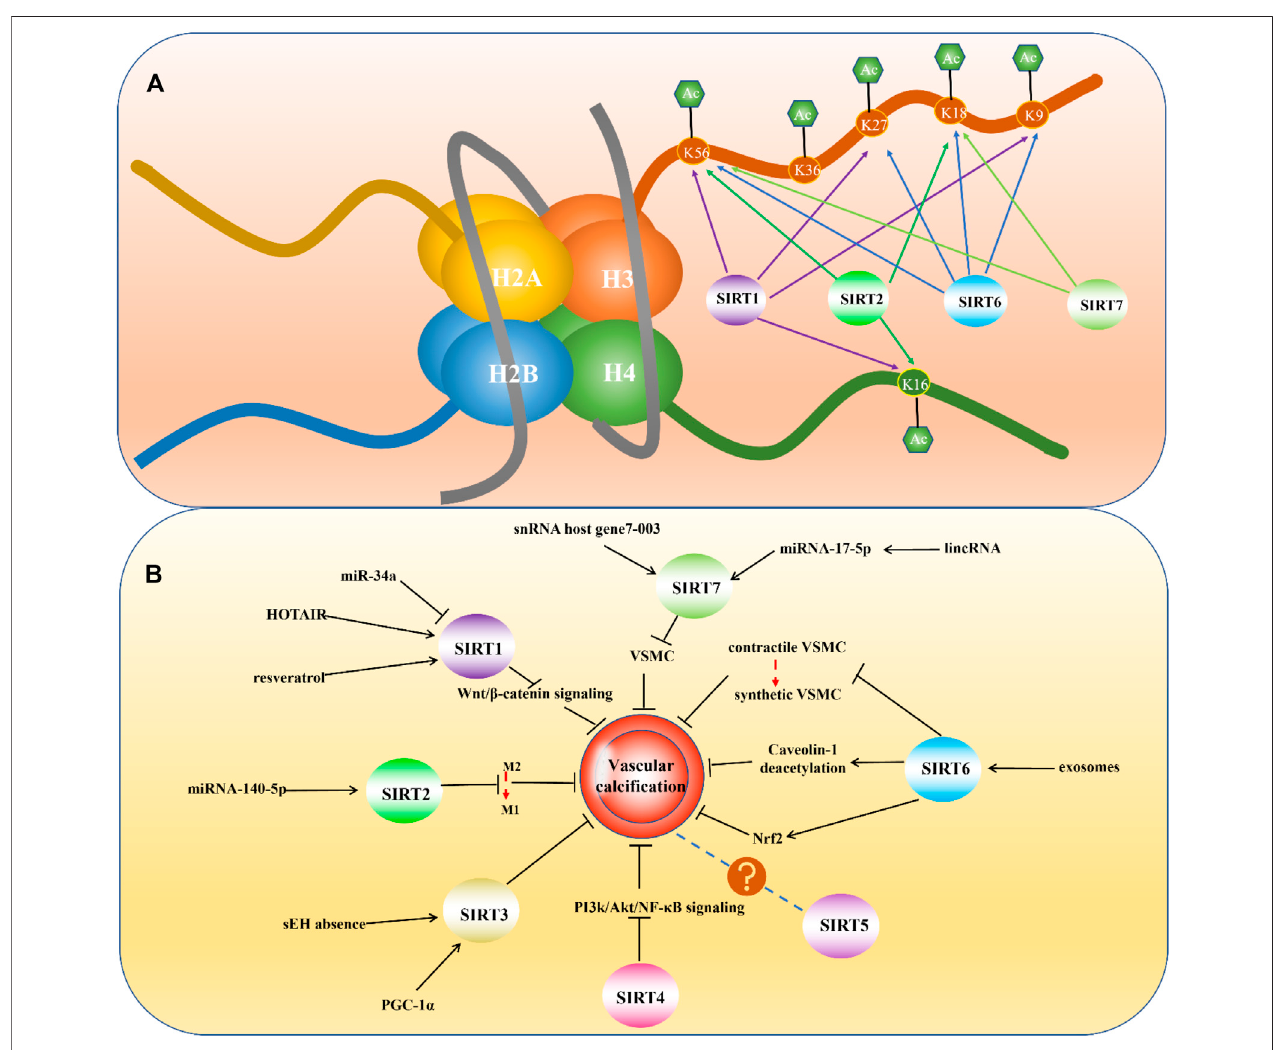
FIGURE 3 | (A) Histone deacetylation sites of mammalian Sirtuins. (B) Mammalian Sirtuins and their Relevance in Vascular Calci fi cation.